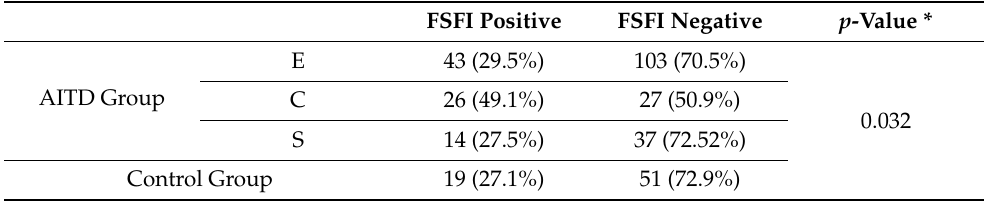
Table 5. Comparison between the categories of patients with AITD and healthy patients in terms of diagnosis of female sexual dysfunction according to the FSFI scale (percentage